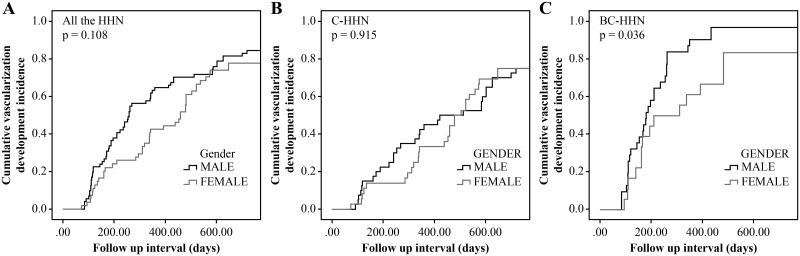
Comparison of cumulative incidence of vascularization development between sex stratified by groups.(A) all the HHN; (B) C-HHN; (C): BC-HHN.